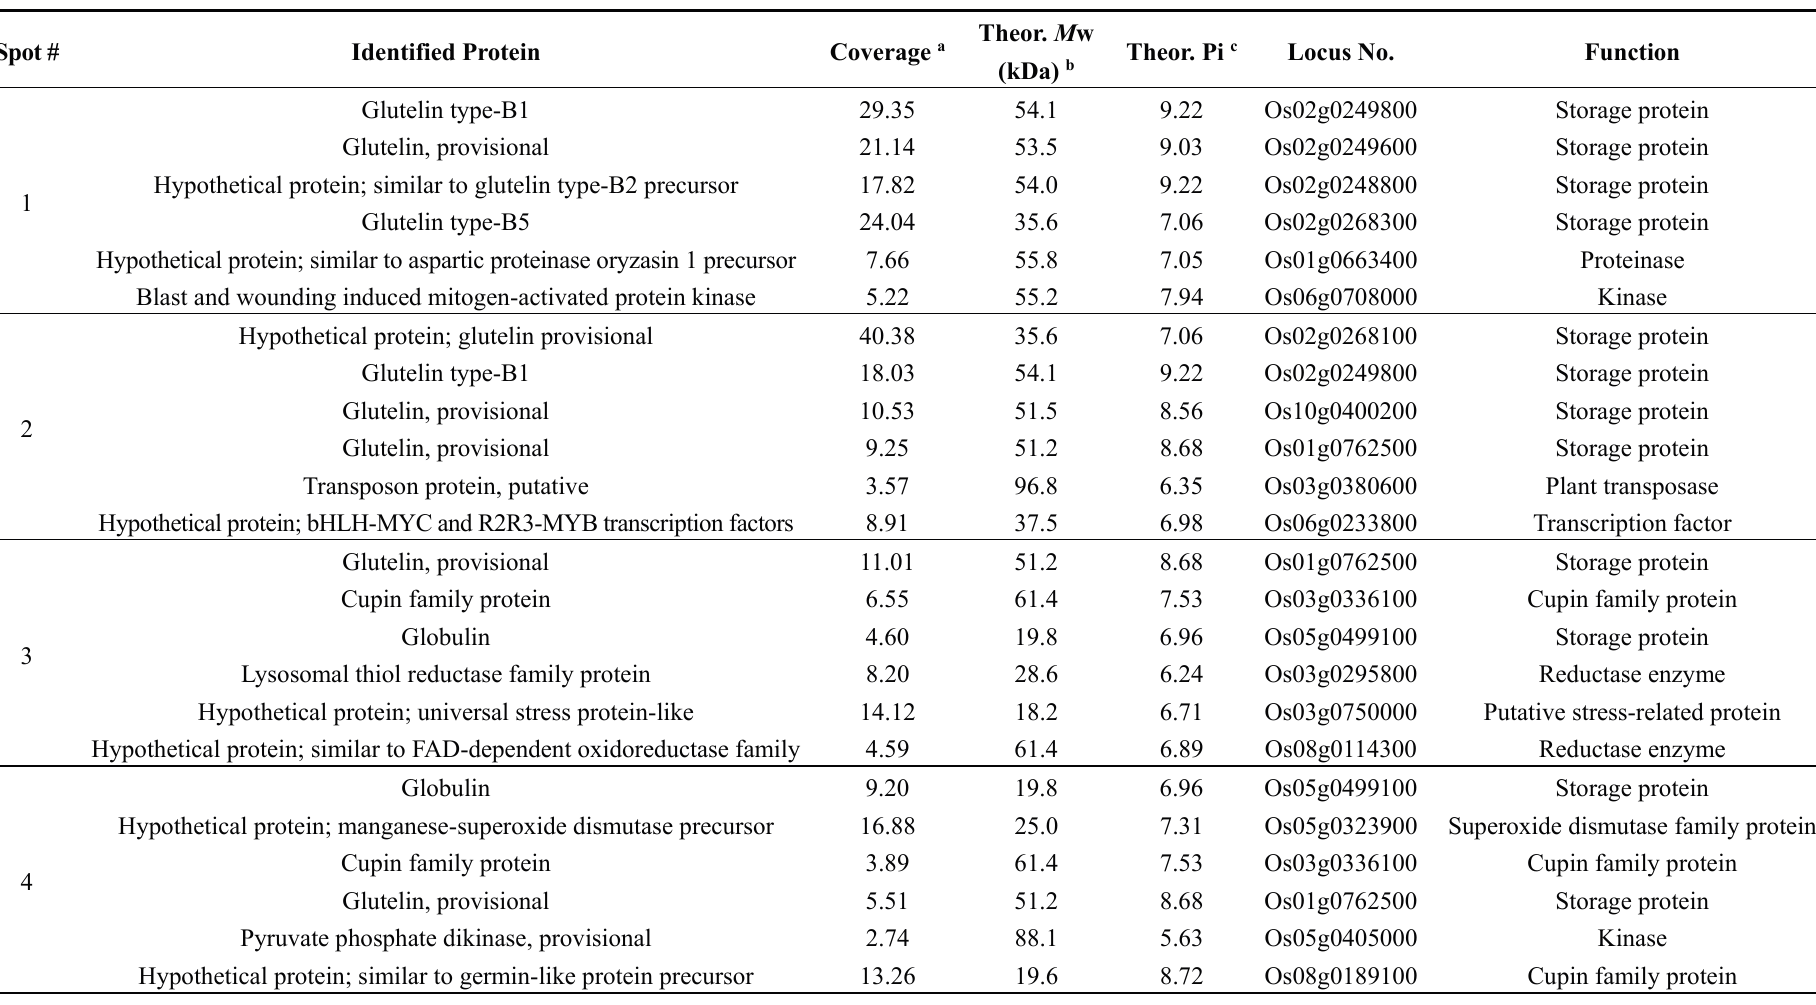
Table 1. Seed protein abundances that differed significantly between wild type and Glb-RNAi lines. Protein spots marked in Figure 5 were excised from the 2-D gels and the proteins were identified with LC–MS/MS and a BLAST search (only 100% matched proteins are included). Spot # Identified Protein Coverage a